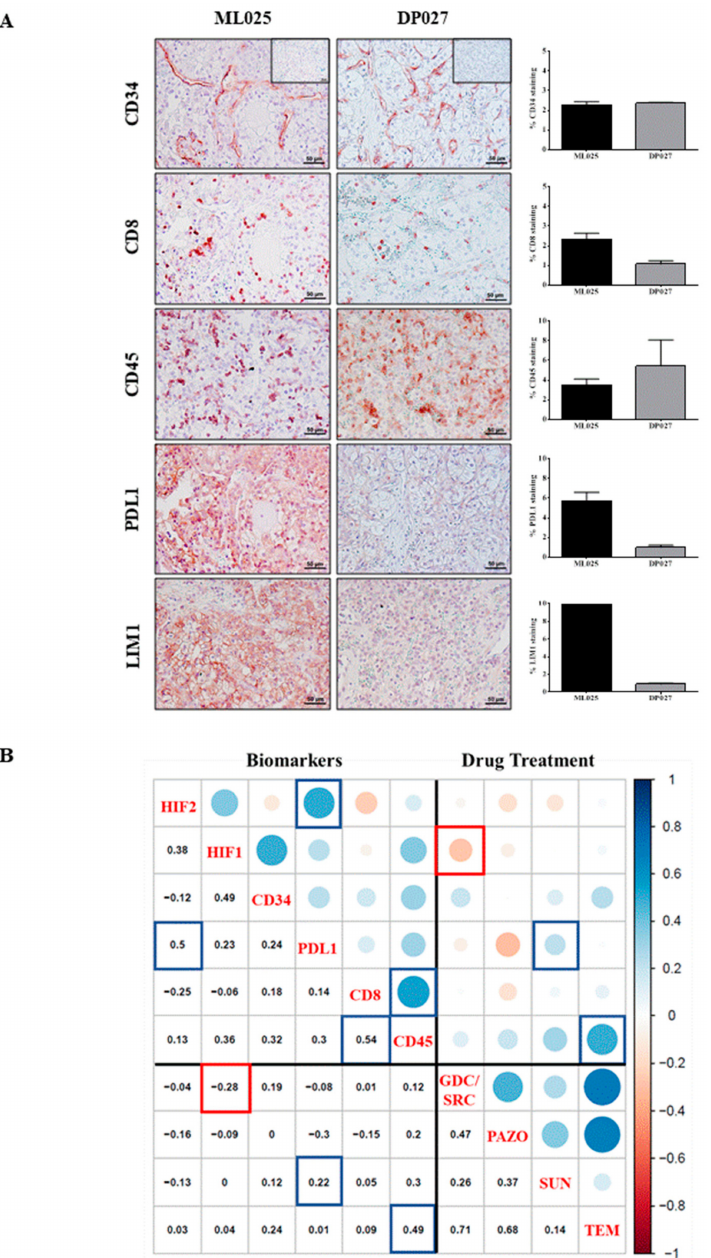
Figure 5. Predictive biomarkers in renal tumor slice cultures. ( A ) Vascular, immune and stem cell type characterization. Representative pictures of untreated tumor slices ML025 and DP027 stained with the following antibodies: anti-CD34, anti-CD8, anti-CD45, anti-PDL1, anti-LIM1. Scale bars, 50 µ m. For each staining, images taken from five independent areas of a tumor slice were quantified with ImageJ and plotted ( right panels ). ( B ) Correlation plot between the percentage of positive cells following various IHC staining and the normalized proportion of dying cells following application of drug treatments. The Spearman rank correlation was used. The diagonal indicates the biomarker used for the IHC staining ( left part ) or the drug treatment ( right part ). Below the diagonal is the pairwise correlation value, and above the diagonal is the corresponding representation, with the color legend that is the bar on the right side of the plot. Blue (resp. red) colors correspond to positive (resp. negative) correlations. Boxes correspond to cases described in the text. For example, the two blue boxes on the top-left side highlight a correlation of 0.5 of the percentage of positive cells between HIF2 and PDL1